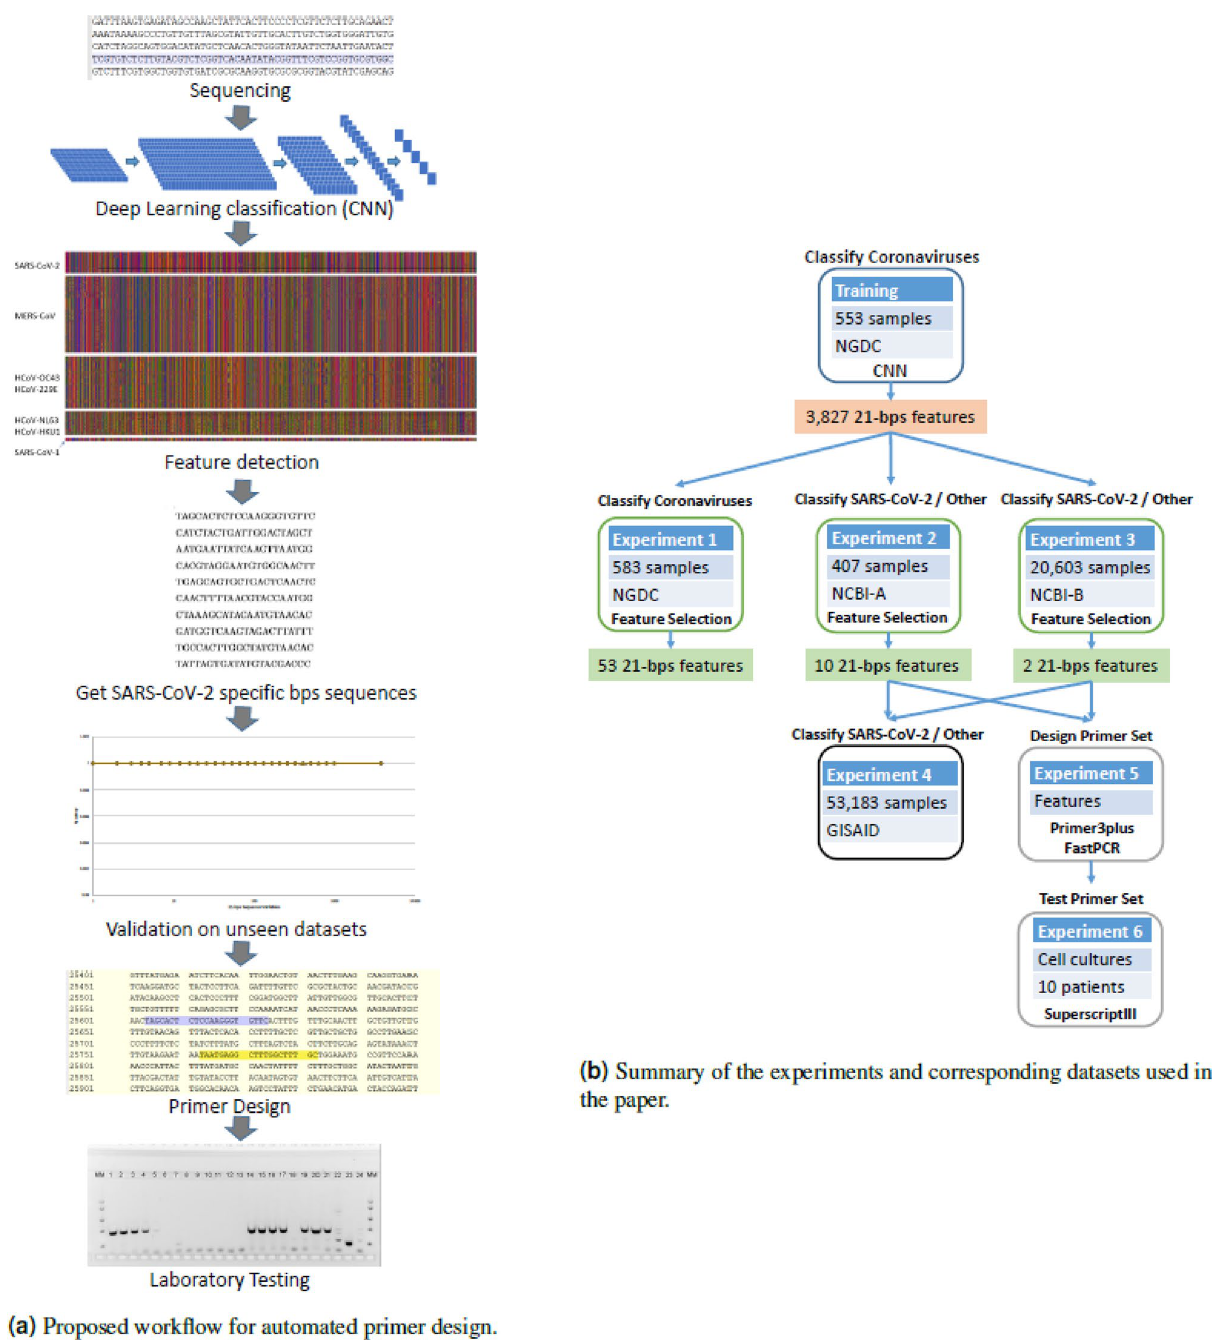
Figure 1. On the left, ( a ) shows the proposed workflow for the automated design of primers for viruses. On the right, ( b ) summarizes the different experiments reported in the paper, along with the datasets used in each